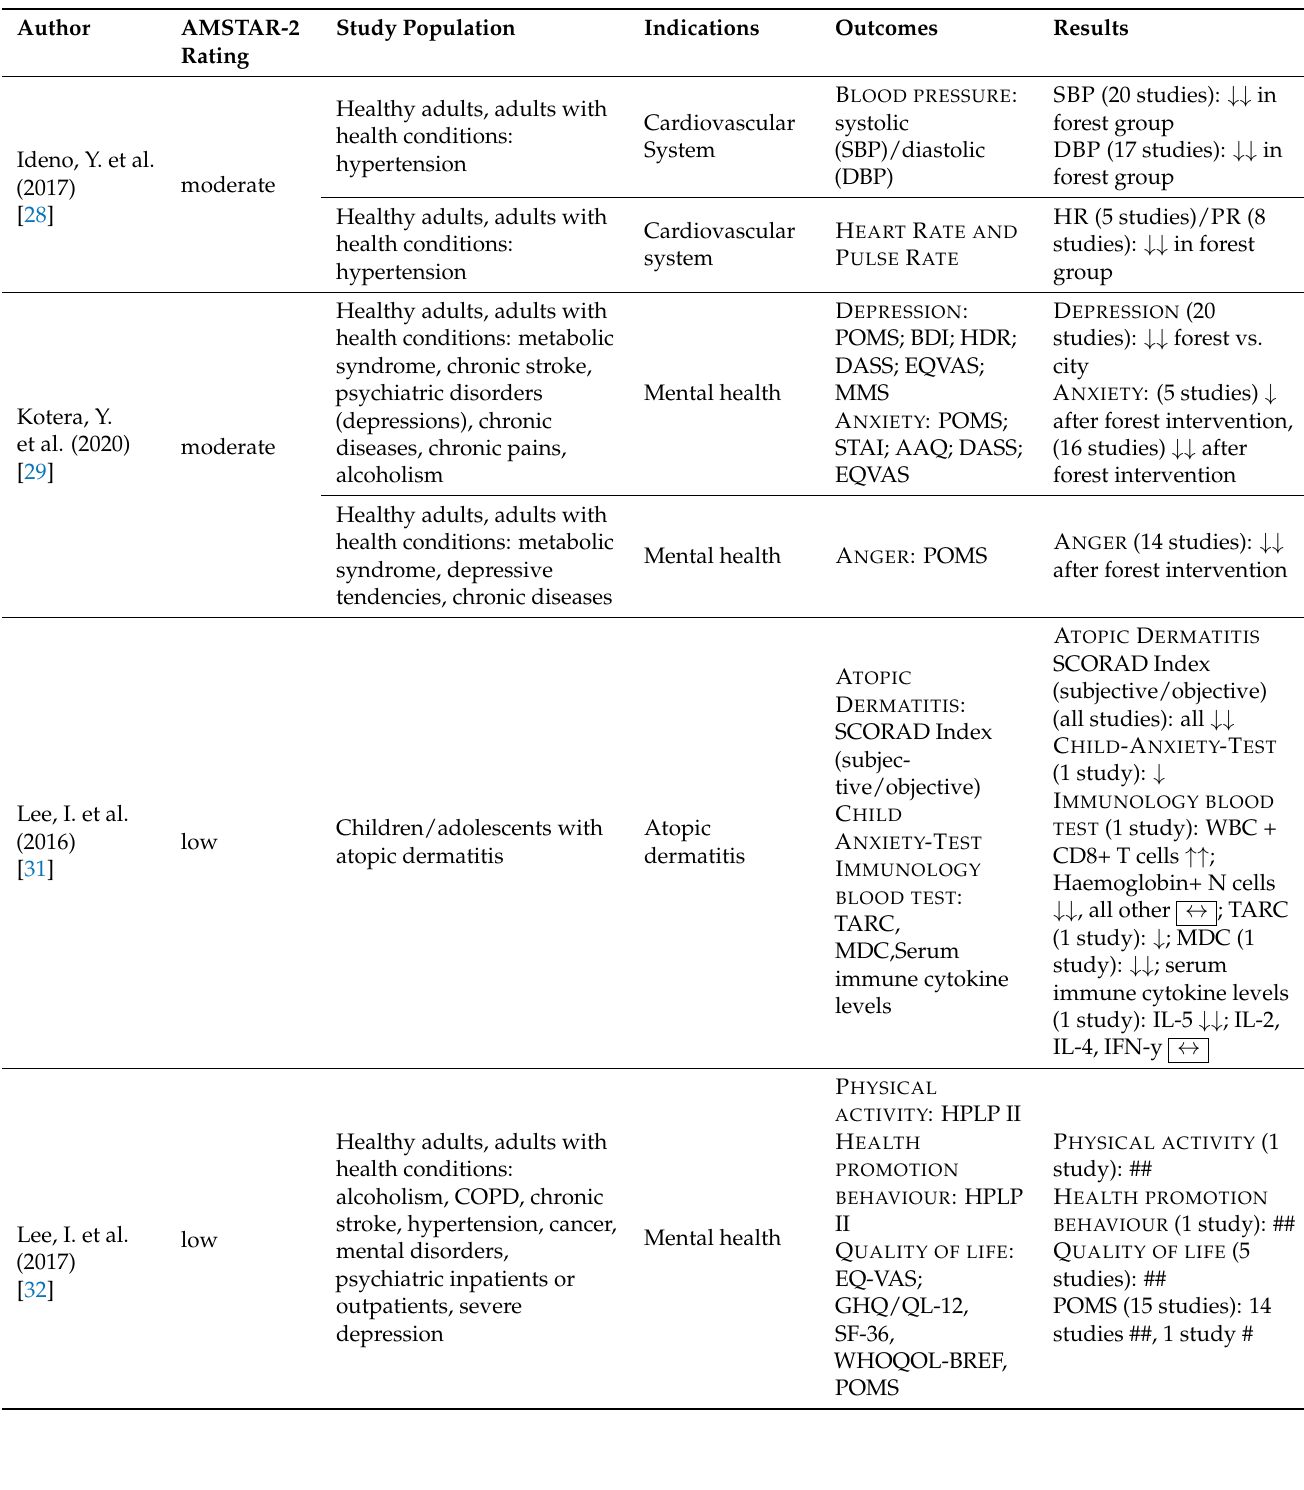
Table 2. Summary of included reviews and meta-analyses—study populations, indications, and results of the included primary studies, arranged in descending order by methodological